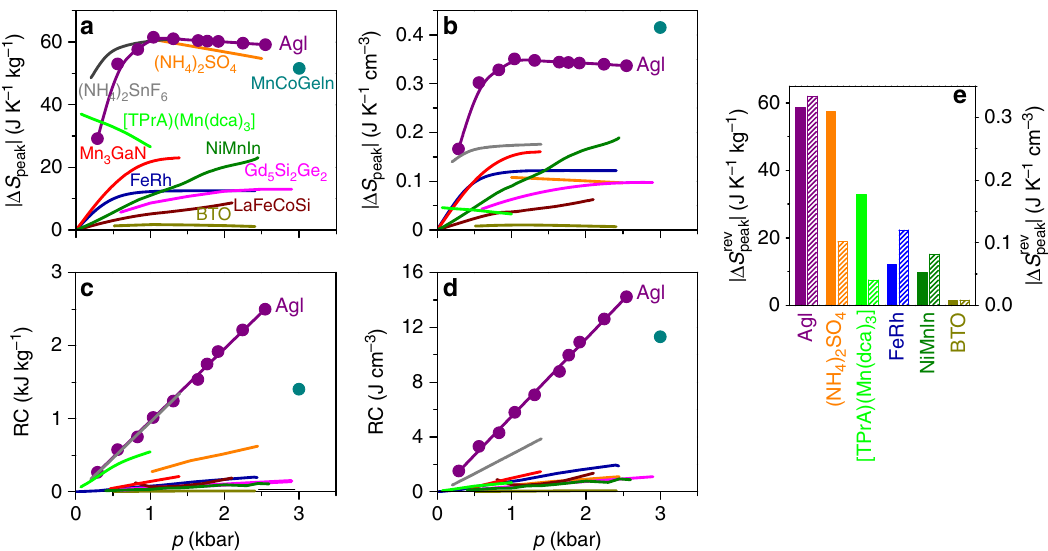
Fig. 4 Comparison of BC effects. For AgI and other BC materials 11 – 16, 20 – 23 , we show for pressure changes | Δ p | of magnitude ~ p both a , b peak values of the temperature-dependent isothermal entropy change | Δ S peak | , and c , d the corresponding refrigerant capacity RC = | Δ S peak | × [FWHM of Δ S ( T )], as normalized by a , c mass and b , d volume. Solid lines represent fi ts. e The largest values | Δ S peak rev | from a , b that may be achieved reversibly (solid columns represent mass normalization on left axis, shaded columns represent volume normalization on right axis). For clarity, (NH) 4 SnF 6 alone represents the fl uoride compounds 20 . The colour code for BC materials is common to all differential thermal analyser whose resistive heater operates between room tem- perature and 473 K, and an Irimo Bridgman pressure cell that operates up to 3kbar with a pressure-transmiting medium of Therm 240 (Lauda).